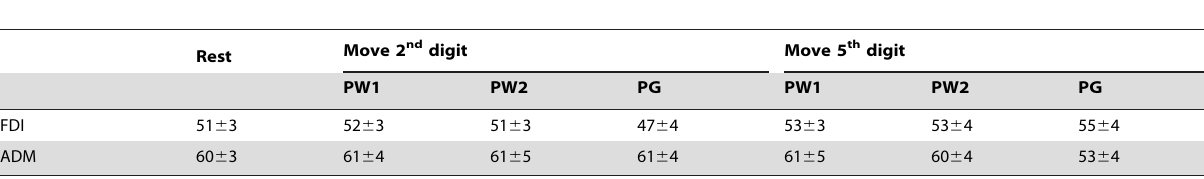
Table 1. Percentage of MSO to obtain , 1 mV MEP in each